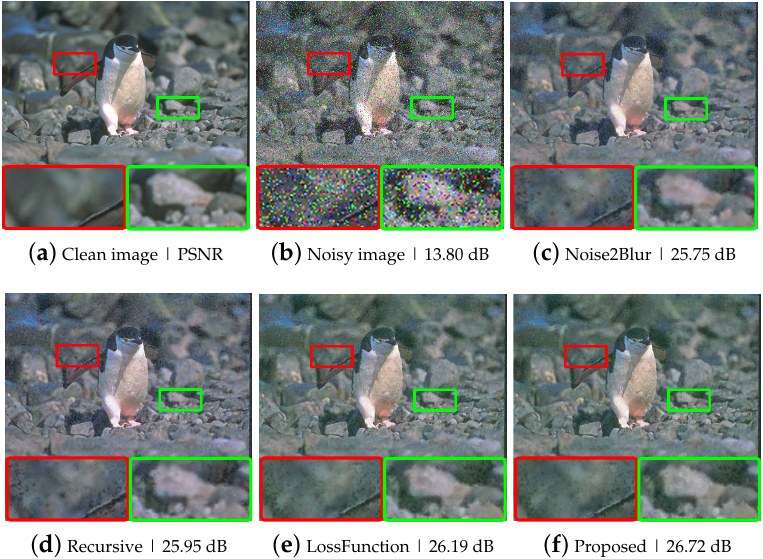
Figure 7. Example images of salt and pepper denoising at p = 0.15: ( a ) a clean image; ( b ) a salt and pepper noisy image; ( c – f ) example images of salt and pepper denoising using various noise removal